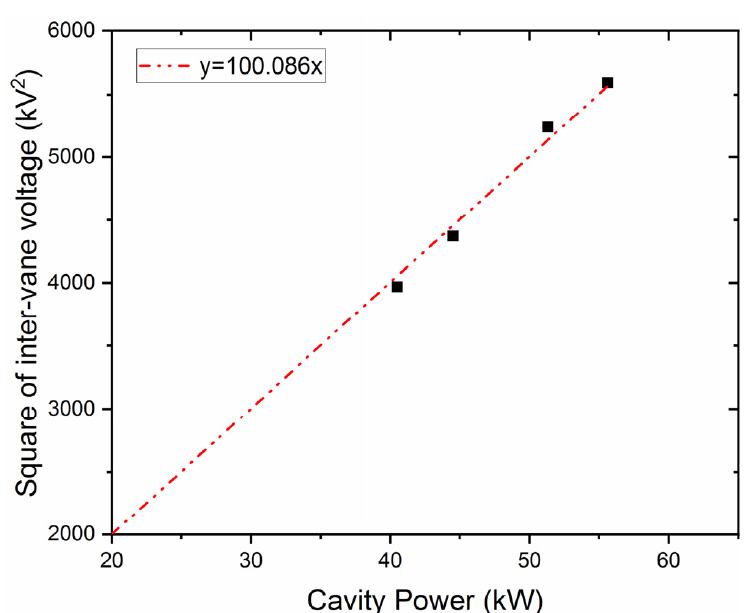
Figure 12. Square of inter-vane voltage as a function of cavity power.